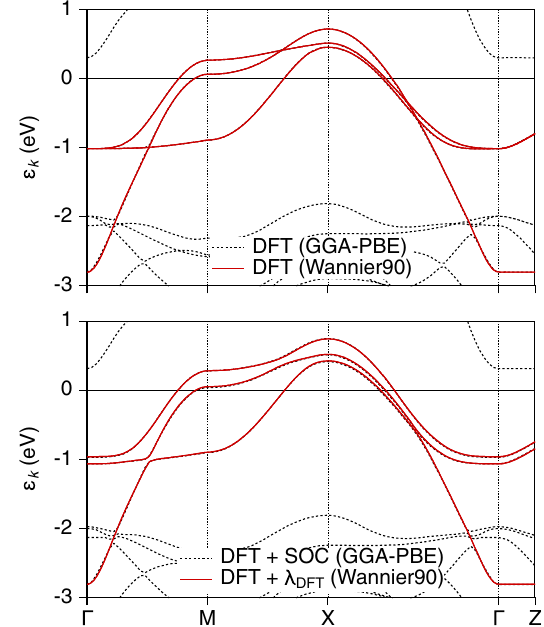
FIG. 9. DFT band structure along the high-symmetry path Γ MX Γ Z compared to the eigenstates of our maximally localized ˆ H DFT Wannier Hamiltonian for the three t 2 bands. Top panel: g ˆ H DFT DFT (GGA-PBE) and eigenstates of . Bottom panel: DFT þ ˆ H DFT ˆ H SOC SOC (GGA-PBE) and eigenstates of , with a local þ λ DFT 100 SOC term [Eq. (8)] and a coupling strength of λ DFT ¼